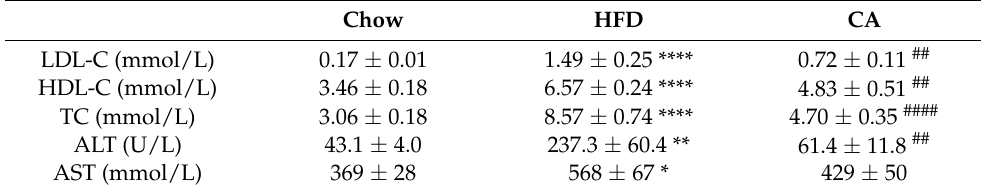
Table 4. Serum biochemical analysis.